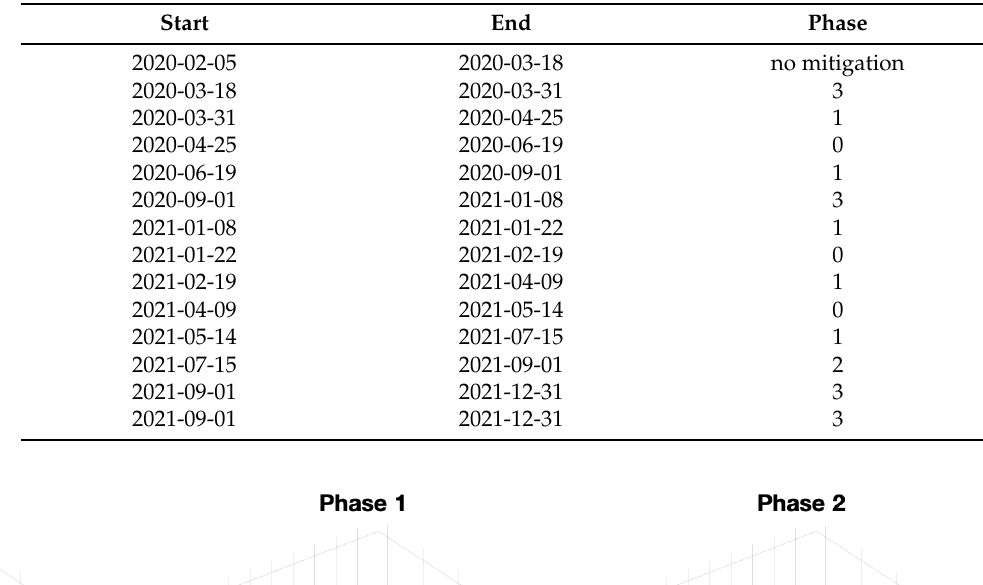
Table A4. Contact mitigation phase.